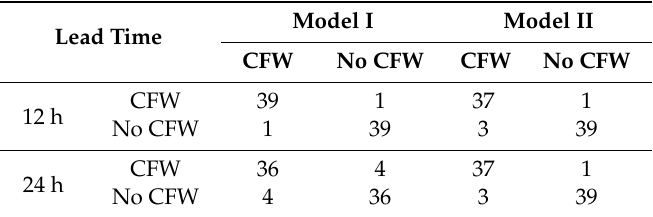
Table 2. Training results of the CFW forecasting models.